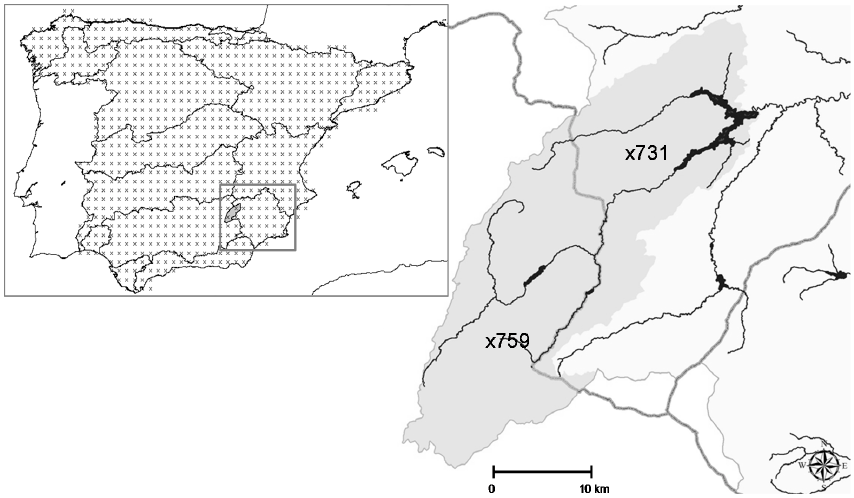
Figure 2. Location of the Segura River Basin in the Iberian Peninsula, and the Fuensanta Basin with the selected sites (731 and 759) for the